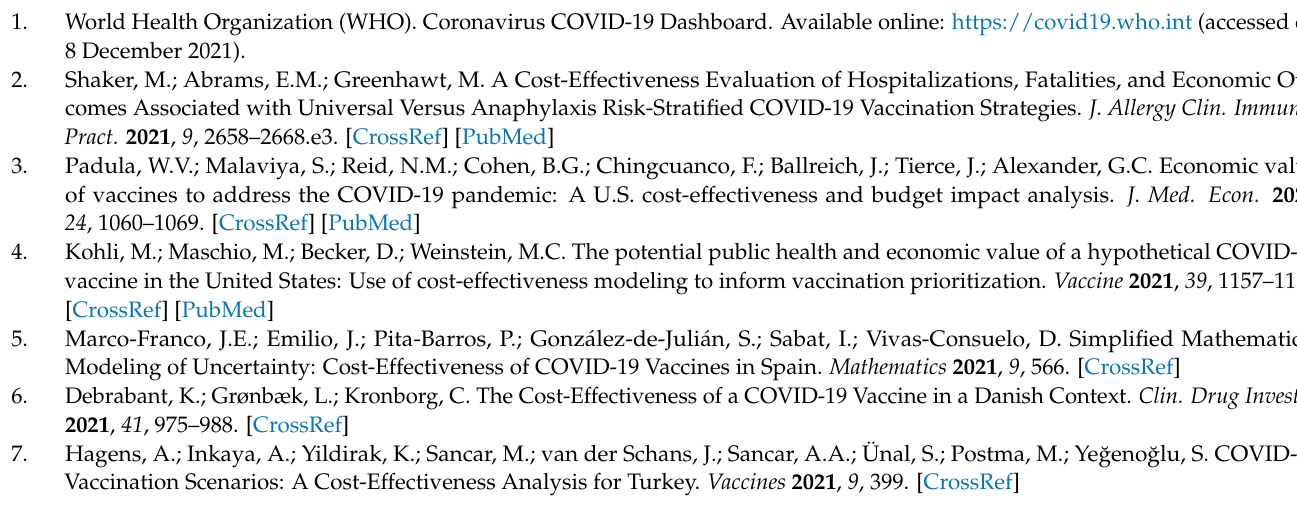
demic; Table S2: Model parameters for people aged over 60 under the Omicron strain pandemic; Table S3: Cost-effectiveness analysis of different sequential vaccination strategies compared with ini- tial inoculation under the Omicron strain pandemic; Table S4: Cost-effectiveness analysis of different sequential vaccination strategies among age-specific